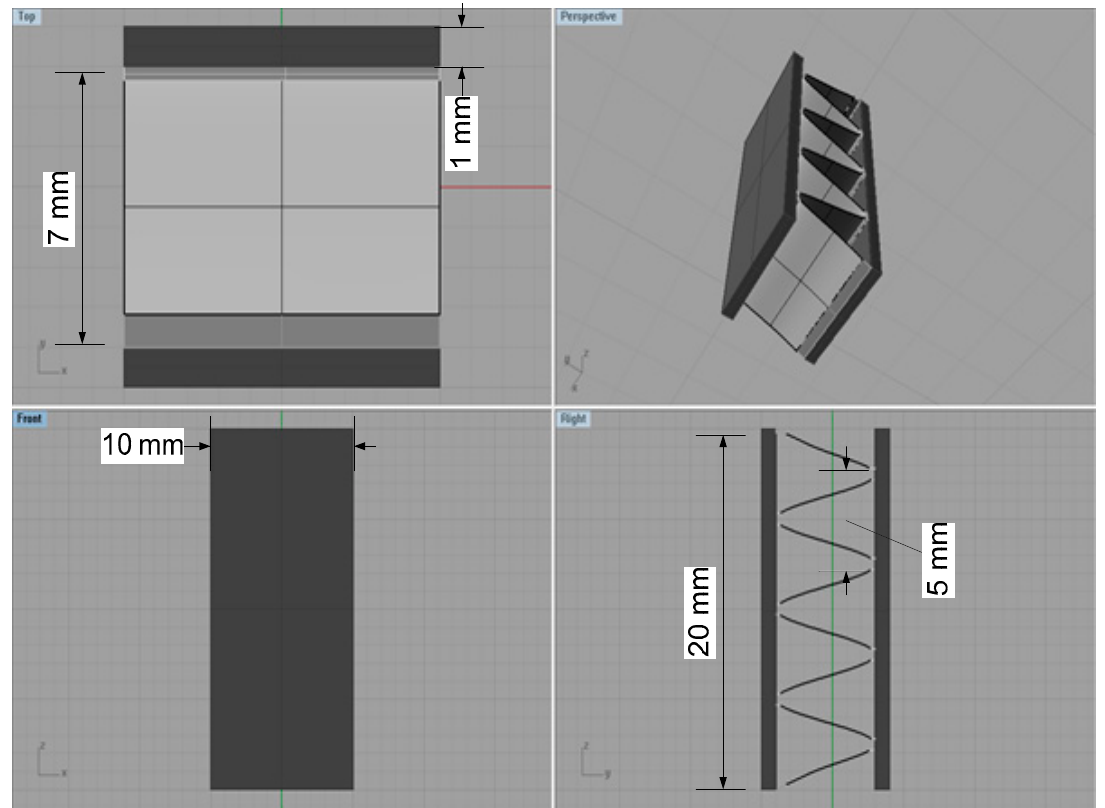
Figure 3. 3D models of the Al fin-tube heat exchanger with detailed dimensions (view of top, front, right and perspective).